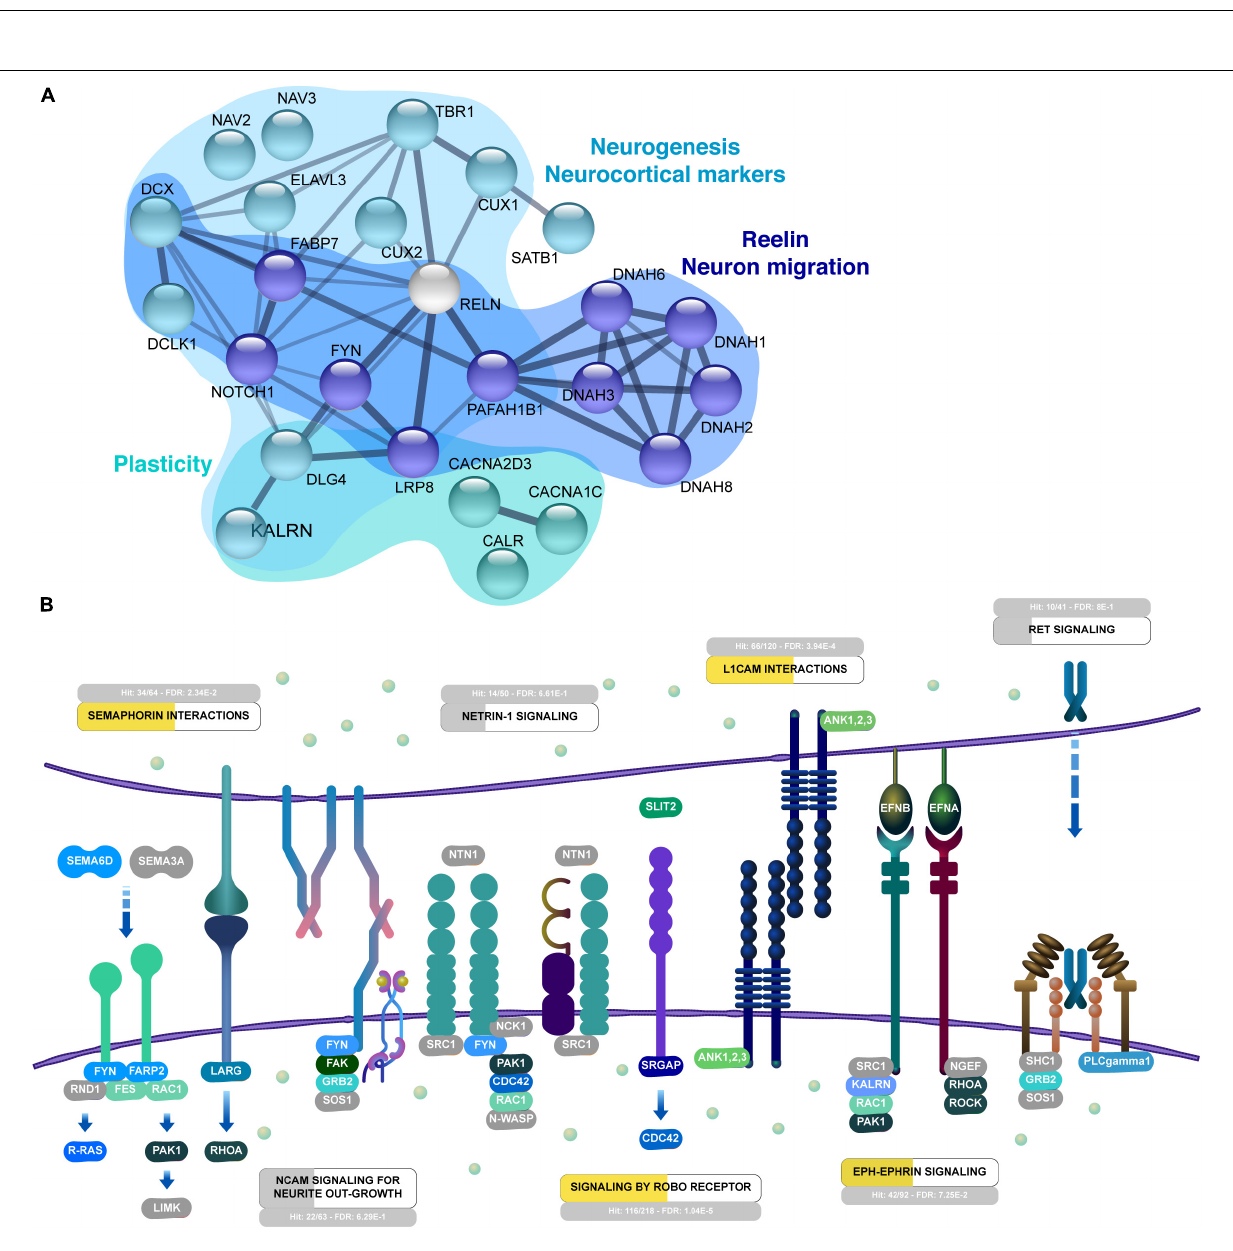
FIGURE 6 | Interactive organization of proteins from 45-day cerebral organoids. (A) Network representation of selected proteins related to neurogenesis, reelin and migration of neurons, and synaptogenesis. Networks are based on the STRING database (https://string-db.org/). (B) Neuronal guidance is overrepresented in 45-day cerebral organoids (FDR 2.05E-15). Enriched signaling pathways include semaphorin interactions (FDR 5.14E-4), L1CAM interactions (FDR 9.68E-7), signaling by ROBO receptor (FDR 4.9E-9) and Eph-Ephrin signaling (FDR 3.6E-3). Proteins in NCAM signaling for neurite outgrowth, netrin-1, and ret signaling are partially represented. Overrepresentation analyses were performed with Reactome (https://reactome.org/). Proteins found in proteomics analyses of 45-day organoids are colored in shades of blue and green, while gray proteins were not found in the dataset.